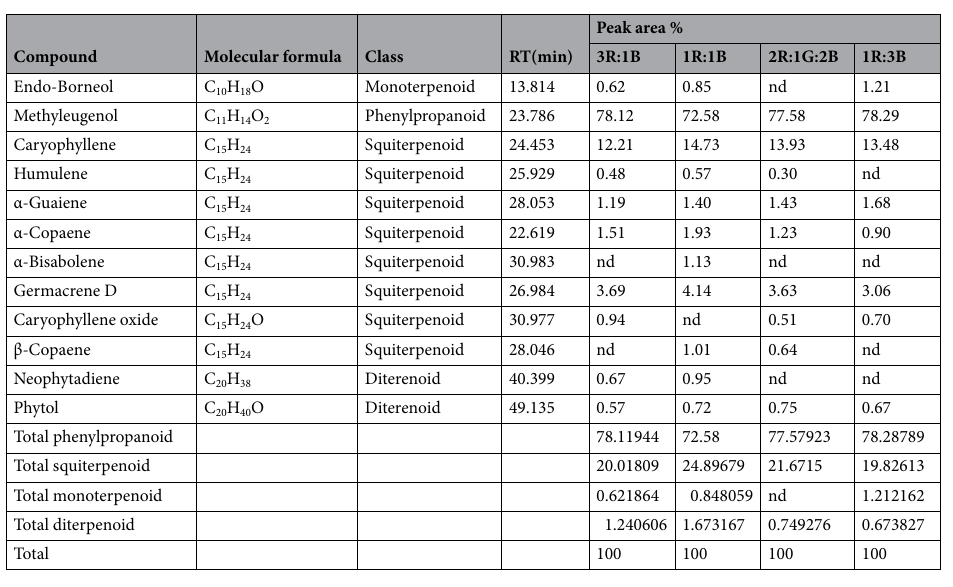
Table 5. Chemical profiling of red holy basil under different light spectrum ratios (3R:1B, 1R:1B, 2R:1G:2B, and 1R:3B) at flowering stage. “nd” indicates not detected . R, G and B represent the red, green and blue llight spectra, respectively, and number before the letters stand for the ratio of each lighrt